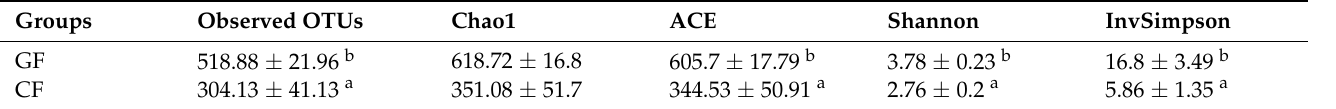
Table 1. Alpha diversity estimates of the bacterial communities (mean ± S.E.; n = 8) 1